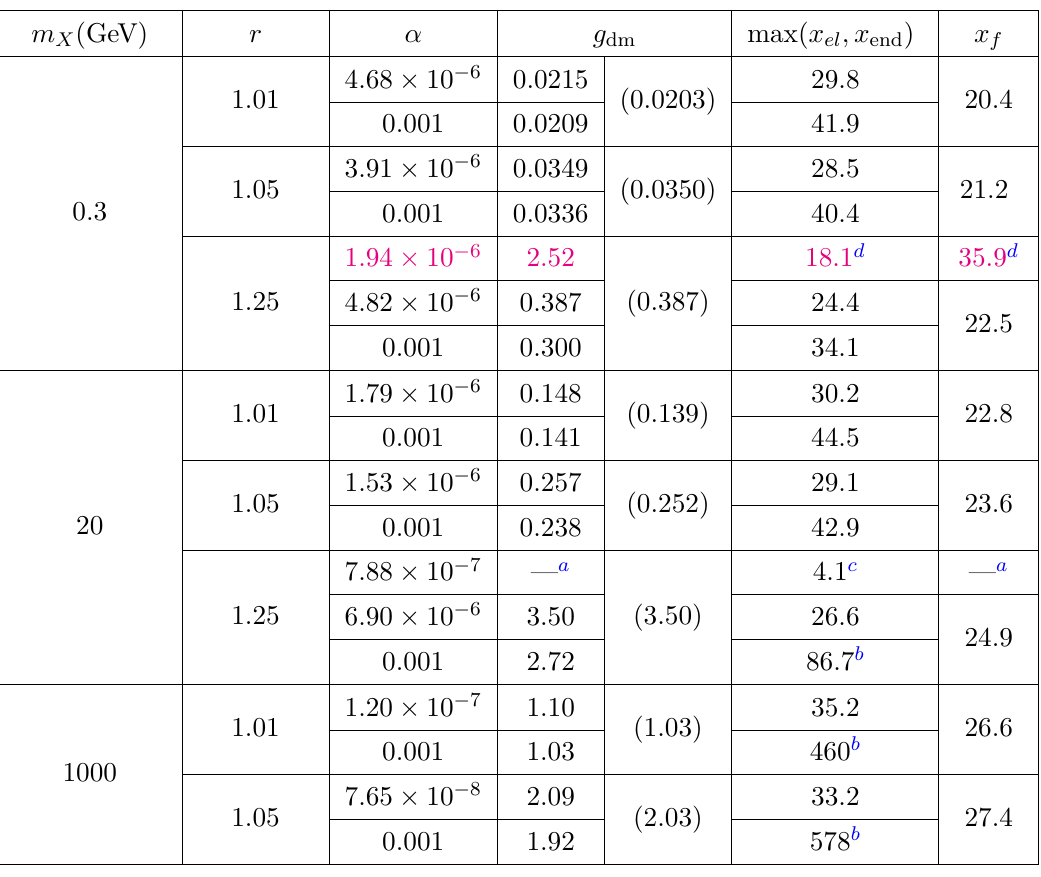
Table 1 . The coupling g dm , which can result in the correct relic density in this forbidden DM model, corresponding to various values of m X (from sub-GeV to TeV), r and α . For comparison, for each set of m X and r , two or three different α are considered; one is a much smaller value corresponding to the lower bound (see the definition in the text), and the largest one in each set is “0.001”. For r = 1 . 25 , the α value, corresponding to g dm derived from the simplified scenario and resulting in